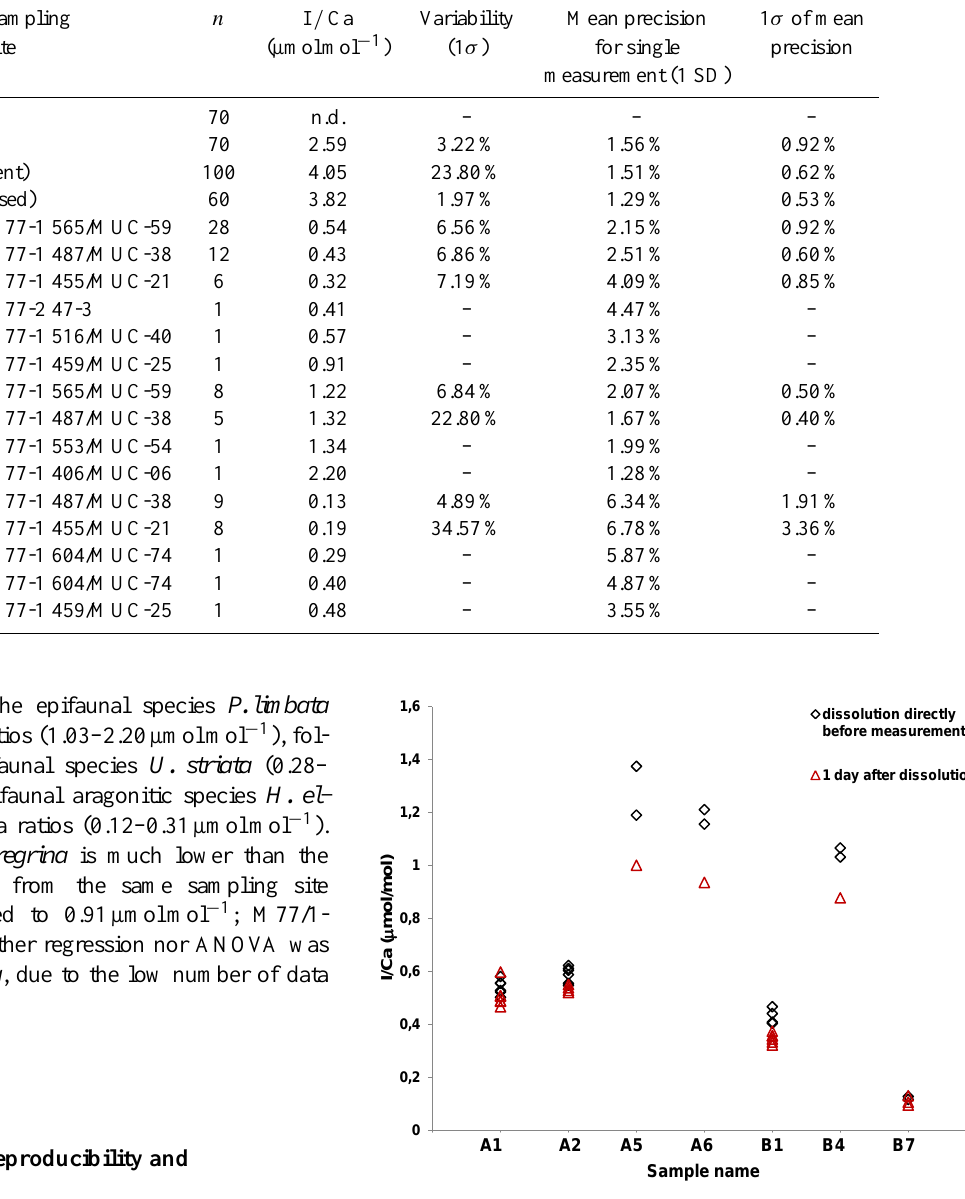
Figure 4. Comparison of I / Ca ratios measured in seven different samples directly after dissolution (diamonds) and 1 day after disso- lution (triangles). Iodine volatility appears to have a strong influence on the samples within 1 day. For sample specification, see Table 2. The mean precision for the foraminiferal analyses in this study was species dependent: 1 σ mean = 3 . 2% ( U. striata n = 65), 4.21% ( U. peregrina n = 2), 2.0% ( P. limbata n = 18) and 7.4% ( H. elegans n =